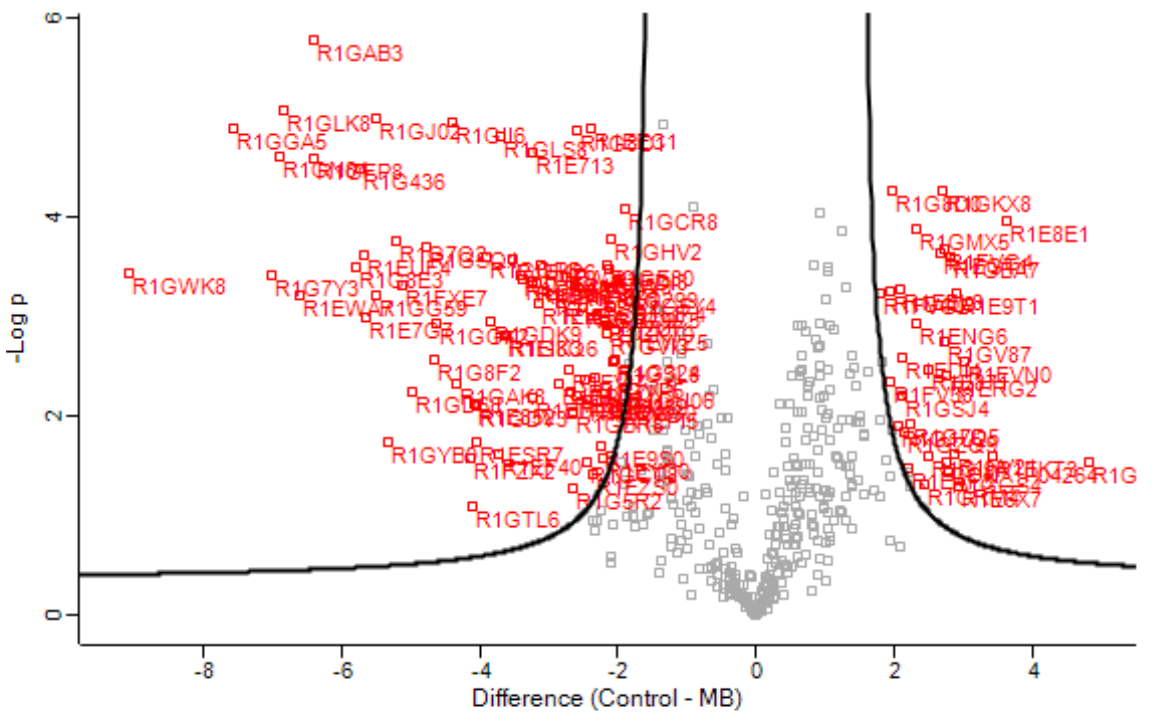
Figure 3. First volcano scatterplot of the samples under analysis. Proteins with a fold change < − 2 or >2 are presented in red, and the remaining ones are in grey.